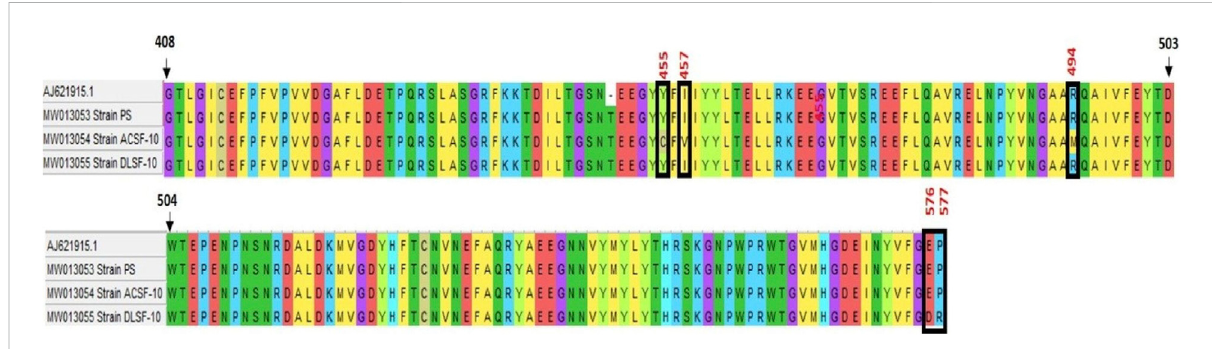
FIGURE 9 Alignment of translated protein sequence of ace-1 gene in PS (parent susceptible) and ACSF-10 (acetamiprid larval-selected fi lial-10) strains with the rock strain of Aedes aegypti (accession No. — AJ621915.1) using Clustal W (MEGA fi ve software) ( n =